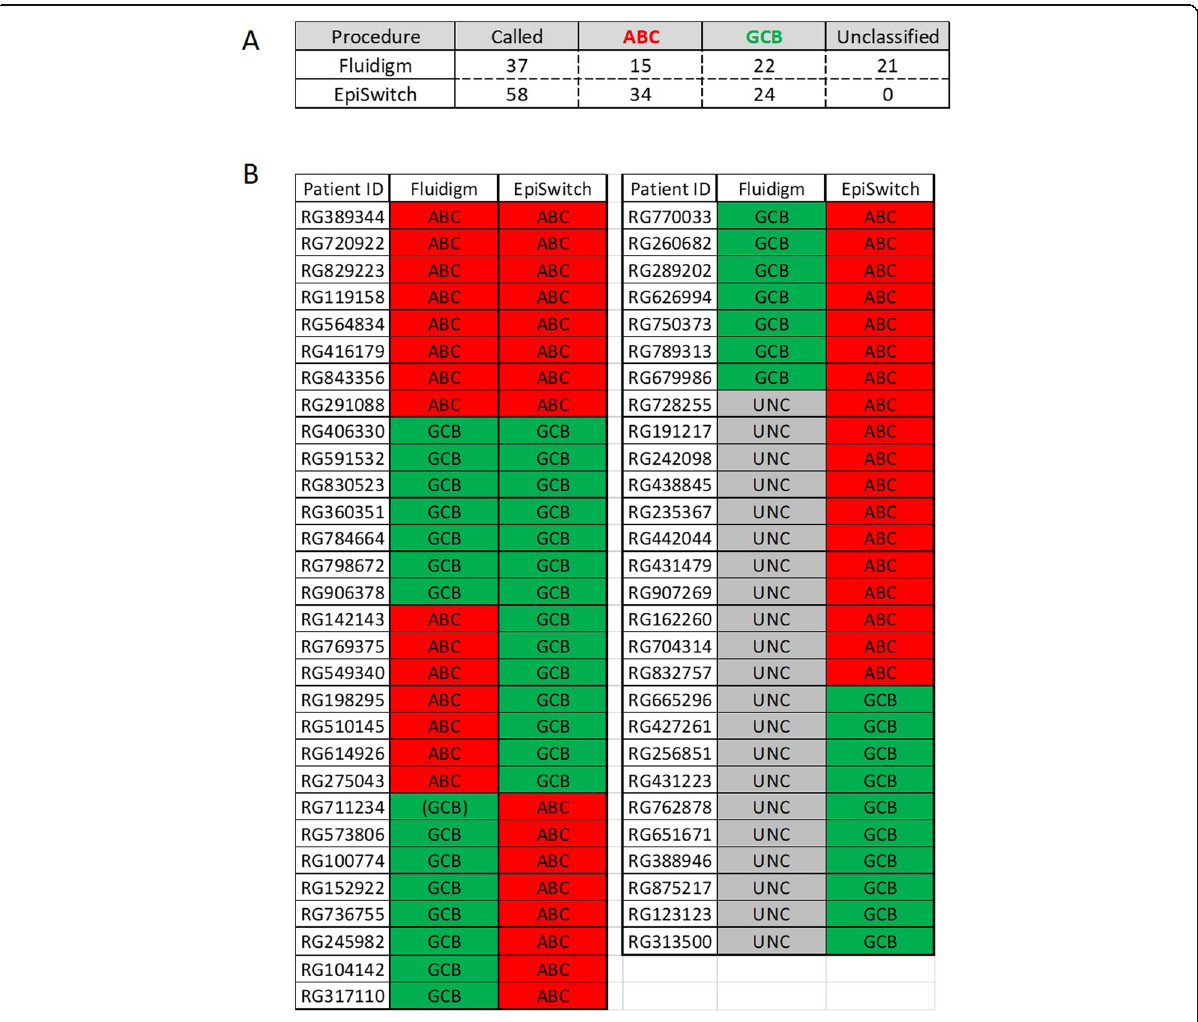
Fig. 4 Assignment of DLBCL subtypes in Type III samples by EpiSwitch and Fluidigm assays. A. Summary of the DLBCL subtype calls made by EpiSwitch and Fluidigm. 21 of the samples were called as “ unclassified ” by the Fluidigm assay (UNC, grey). Of the 37 samples where a subtype call was made by both assays, 15 were called identically as ABC (red) or GCB (green). The remaining 22 samples were called differently by the two